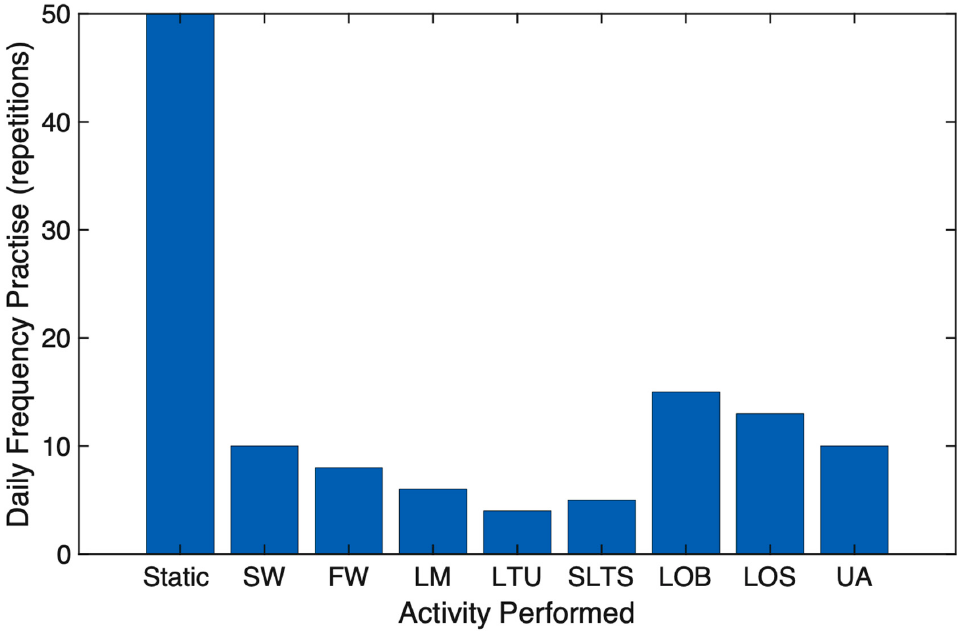
Figure 11 . Overall summary sample of the daily frequency practice of the activity movement performed by a young healthy subject.